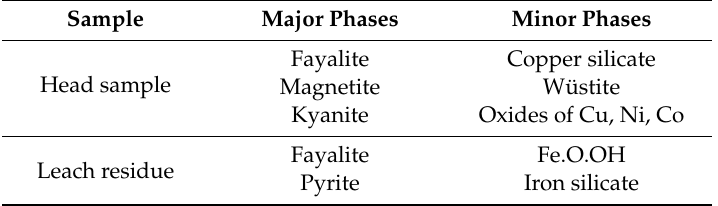
Table 5. XRD phase analysis of copper converter slag and